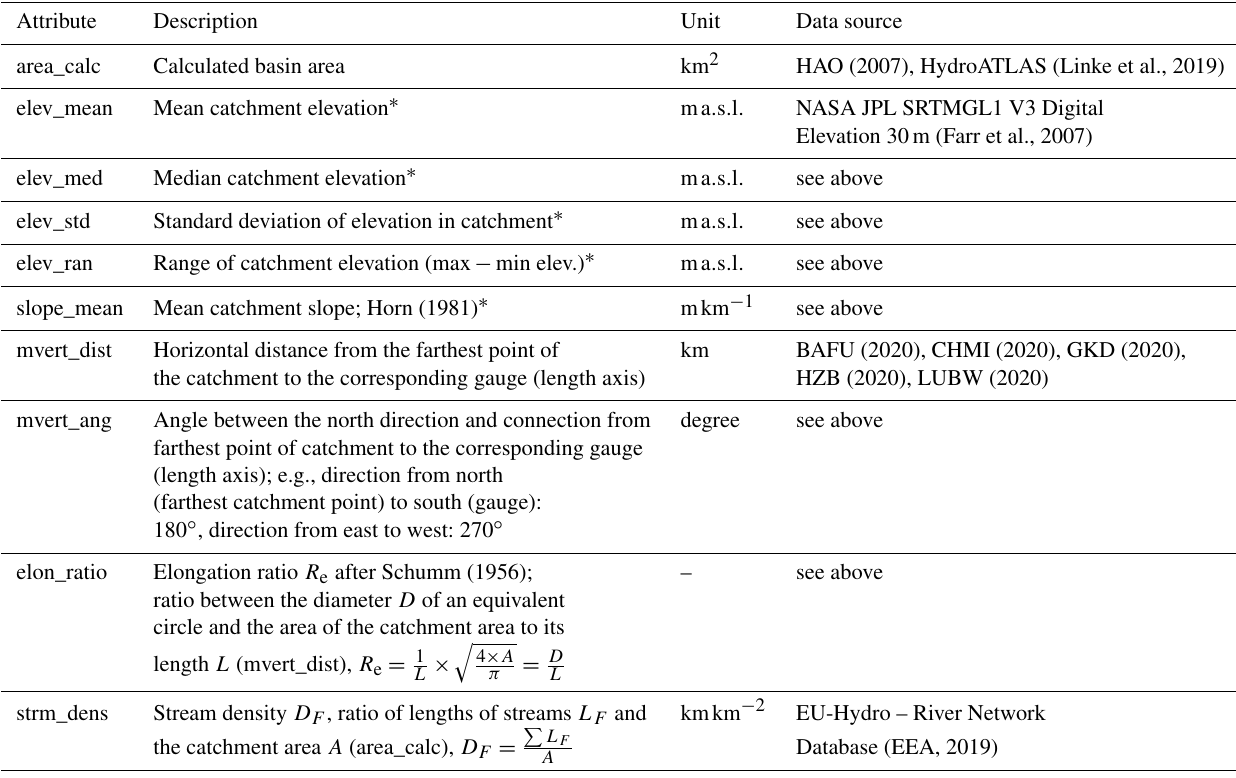
Table A3. Topographic